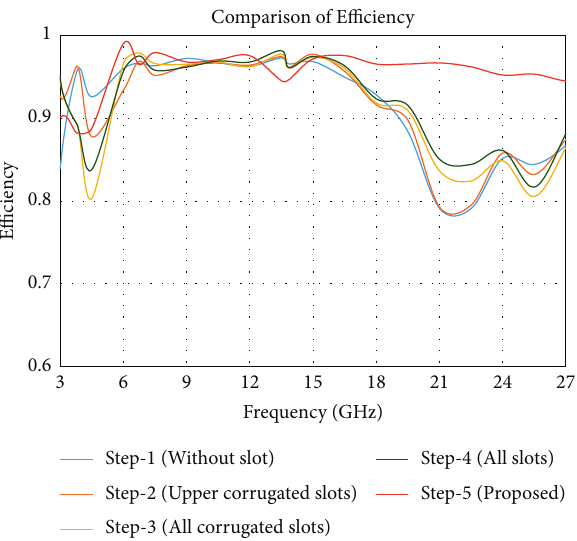
Figure 4: Efficiency curve for different evolution stages.